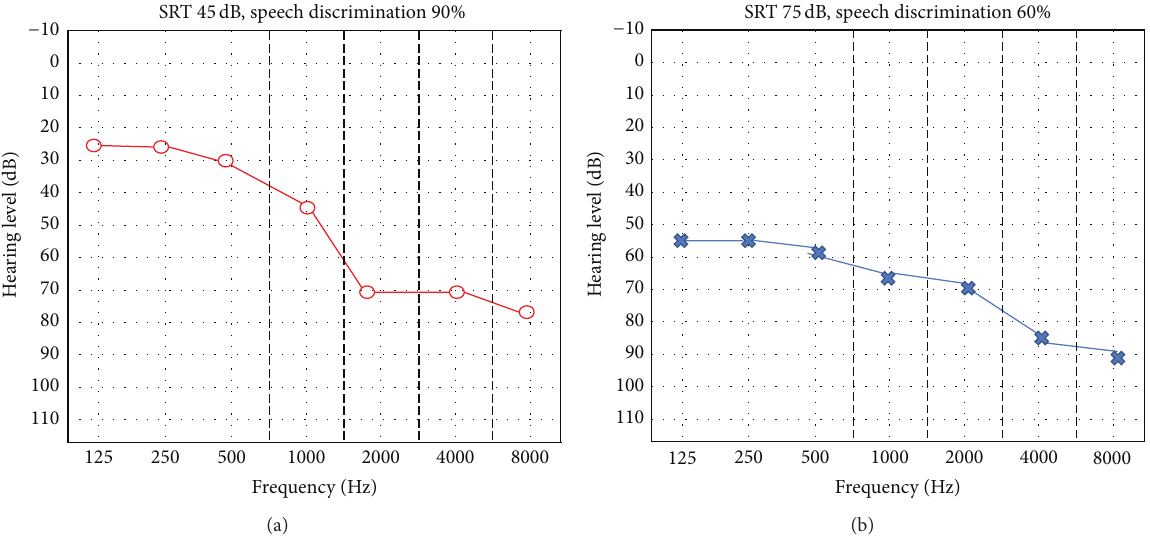
Figure 1: Initial audiogram, overlapping the audiogram 1 day before initiating hyperbaric oxygen therapy.